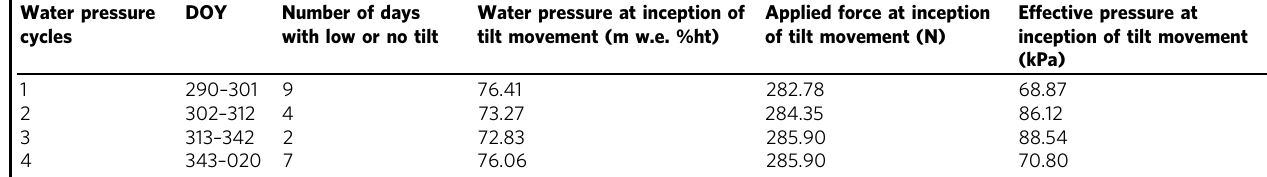
Table 1 The water pressure threshold for the inception of tilt movement for Probe 21 for each water pressure cycle (2009/2010) Water pressure DOY Number of days Water pressure at inception of cycles with low or no tilt tilt movement (m w.e.